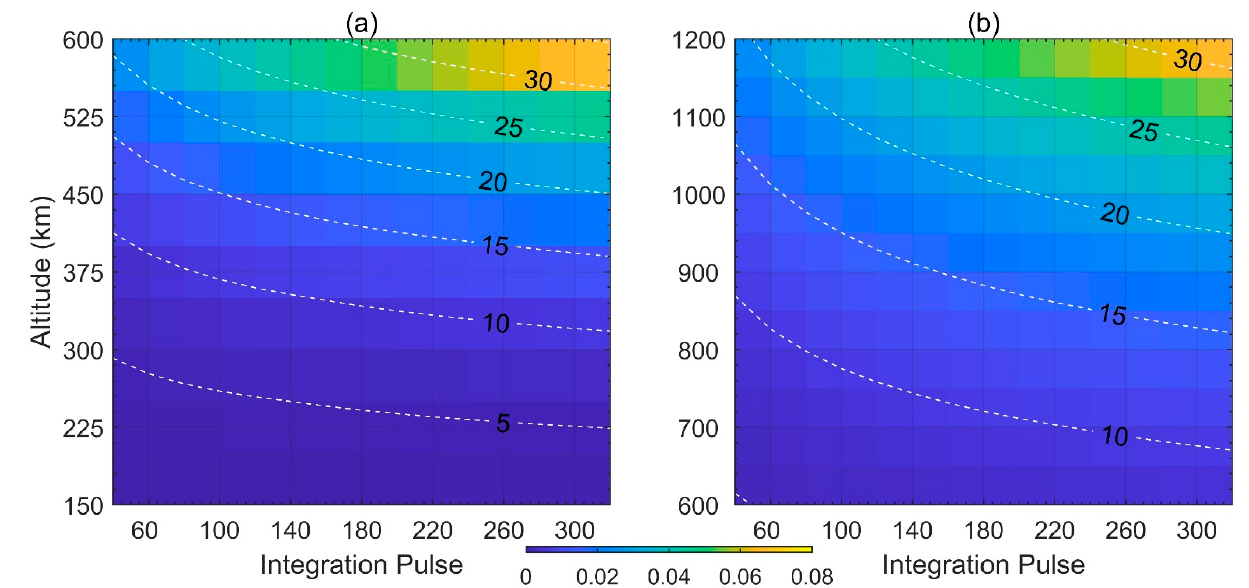
Figure 7. Simulated radar cross section (RCS, color map) and the equivalent spherical diameter (ESD, dotted line) of the space objects that retain the risk of polluting the ionosphere observations by SYISR versus integration pulse number and altitude based on the radar equation. ( a ) The range is 150–600 km with a high ionospheric background (SNR = 6 dB), and the detection threshold of the pollution elimination algorithm is four times that of the background ionosphere. ( b ) The range is 600–1200 km with a low ionospheric background (SNR = 0 dB), and the detection threshold of the pollution elimination algorithm is two times that of the background ionosphere. We used the pulse width of 480 µs in the simulations.